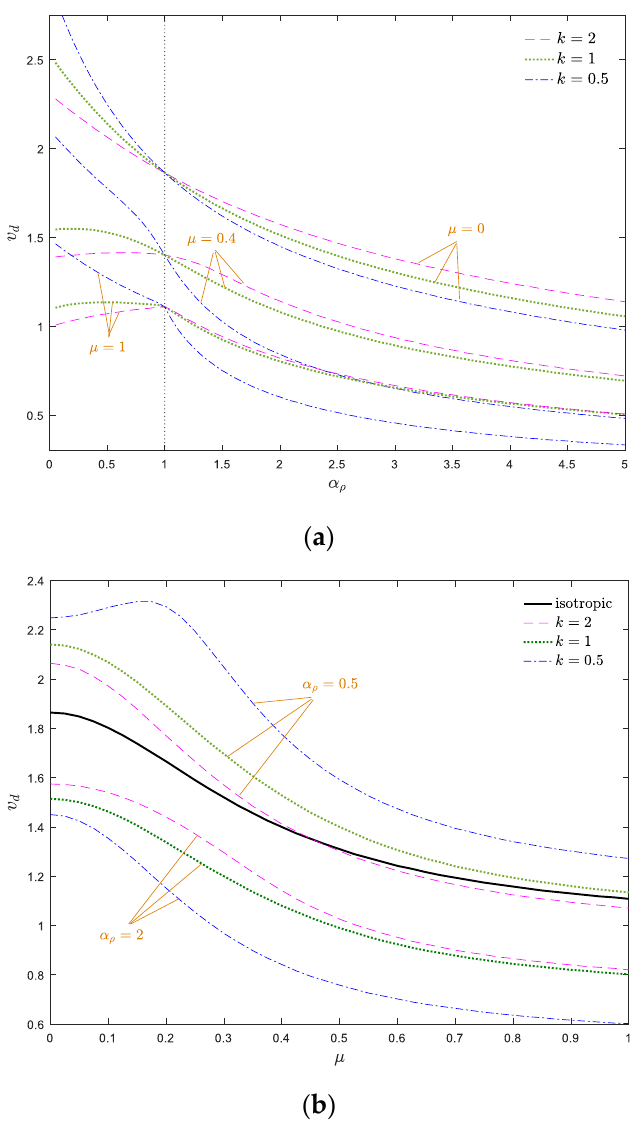
Figure 10. Dimensionless divergence velocity of a nanobeam against ( a ) density gradient parameter and ( b ) nonlocal parameter for ζ = 0, α E = 1, k f = 0.5.